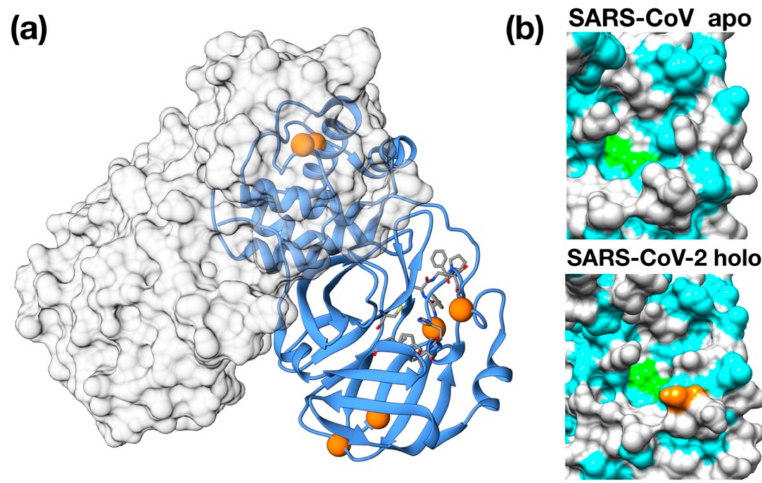
Figure 1. Structural features of 3C-like protease from SARS–CoV-2. ( a ) Homology model structure with chain A shown as ribbons and chain B as molecular surface. Residues mutated with respect to the SARS–CoV homologue are shown as spheres. Active site residues are shown as stick. ( b ) Surface representation of the catalytic site of SARS–CoV Main protease (PDB ID: 5B6O) and of the crystallographic structure of inhibitor-bound SARS–CoV-2 3C-like protease (PDB ID: 6LU7). Hydrophobic residues are shown in cyan. Catalytic residues (His41, Cys145) are shown in green. Ala46Ser mutation is shown in orange on the SARS–CoV-2 structure.